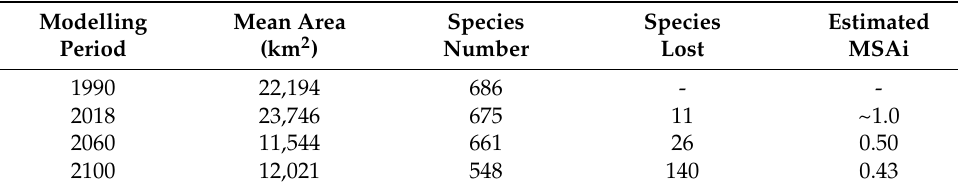
Table 5. Change in habitat extent, species richness and MSAi with time.